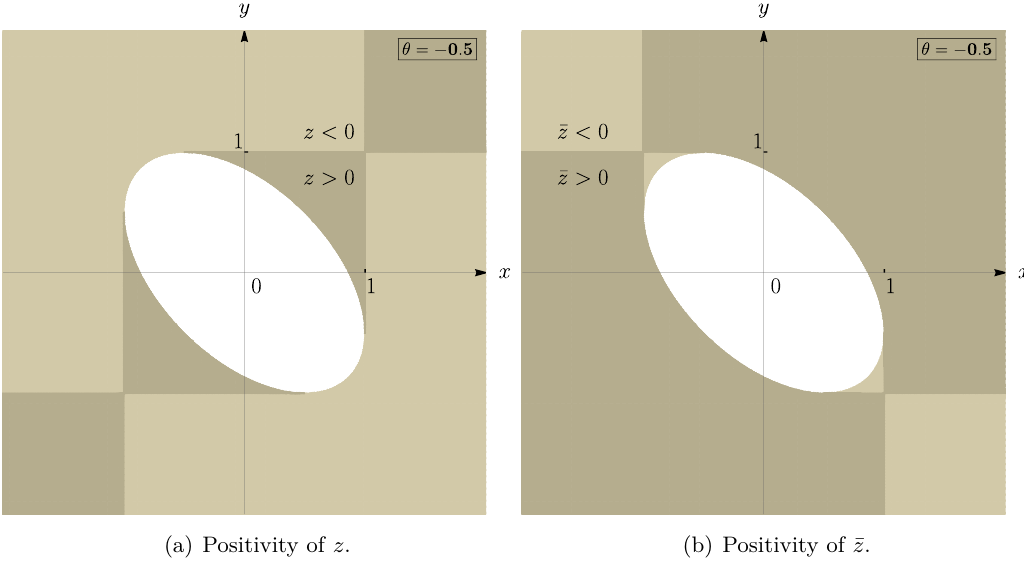
Figure 11 . In this plot we have shown the positivity of z and ¯ z in the ( x, y ) plane by the dark shaded region. In the light shaded region they are negative. White part is excluded since z and ¯ z are imaginary in that